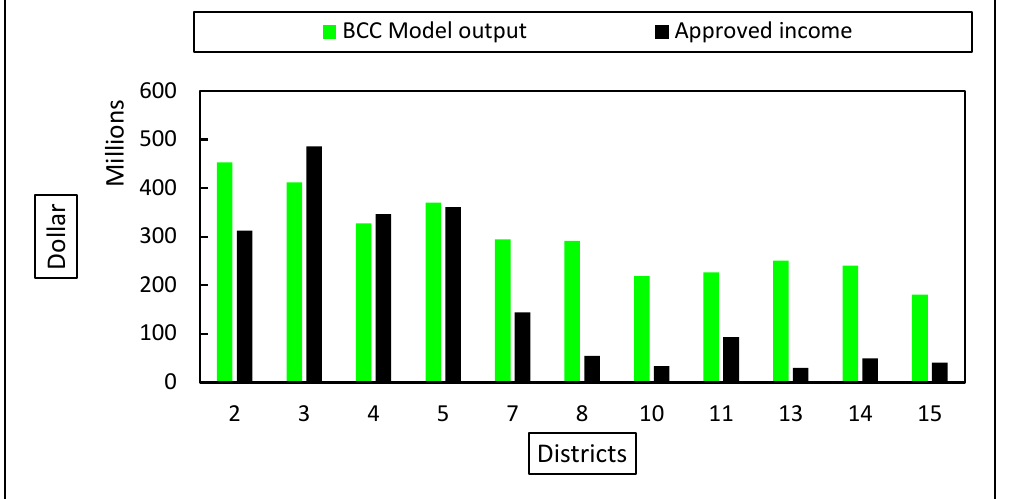
Fig. 6: The proposed value of BCC-O model vs approved cash income